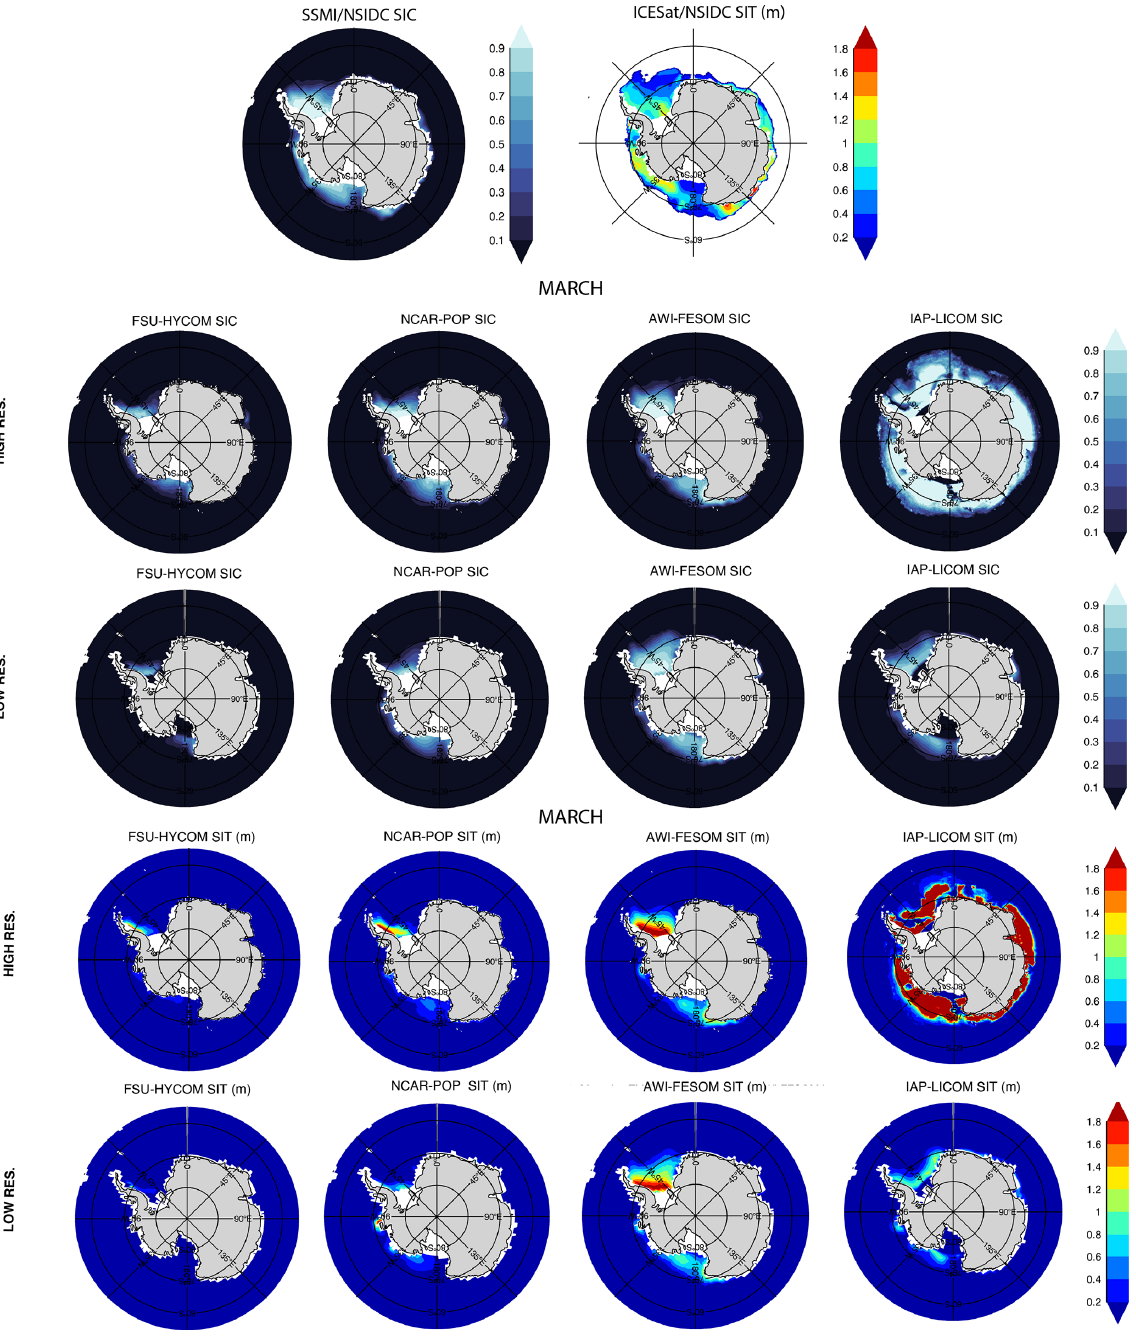
Figure 32. Southern Hemisphere summer mean (March) sea ice concentration (SIC) and thickness (SIT). Top panels: 1980–2018 SIC from passive microwave satellites and 2003–2007 SIT from ICESat. Lower panels: 1980–2018 modeled SIC and